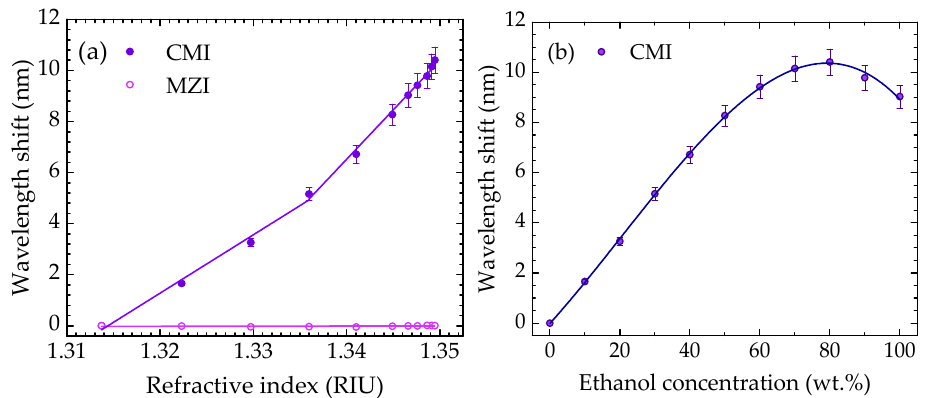
Figure 5. ( a ) Sensor response with refractive index variation for the MZI and CMI components. ( b ) CMI component response for the different solutions.